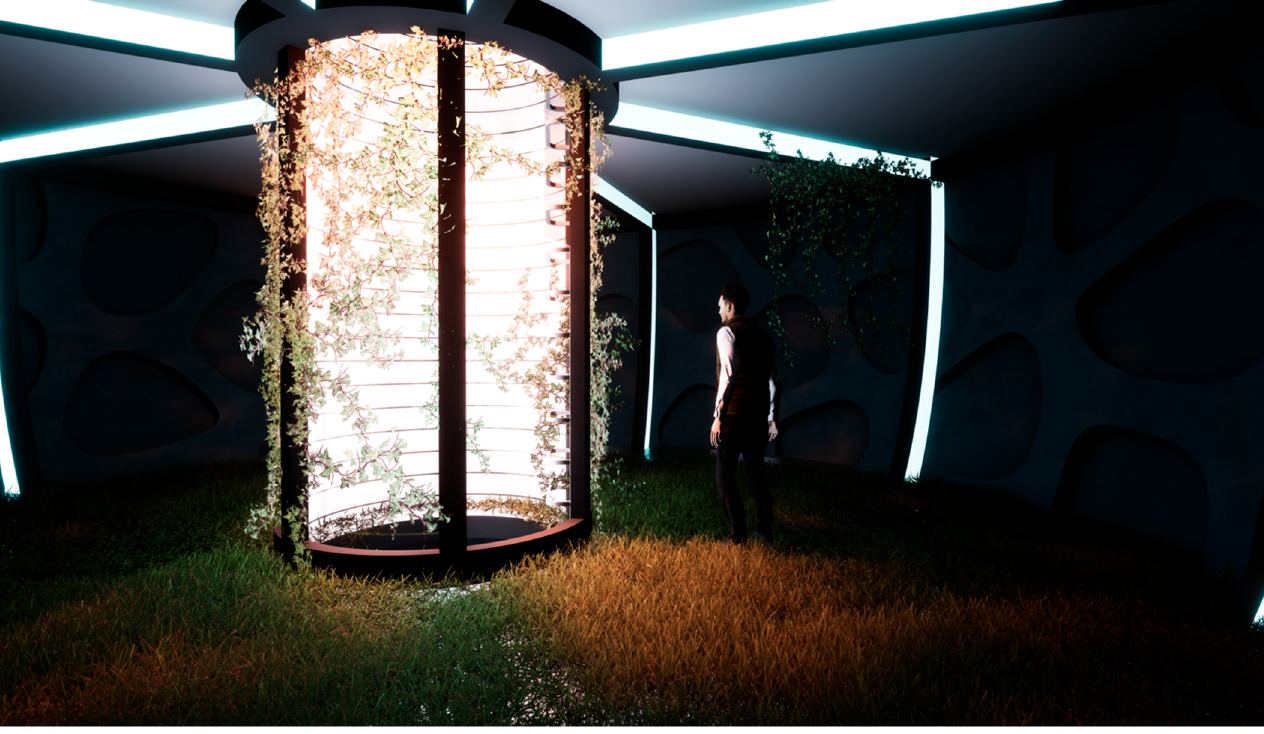
Figure 12. Perspective view of the third underground floor (greenhouse and laboratories) of the habitat. the